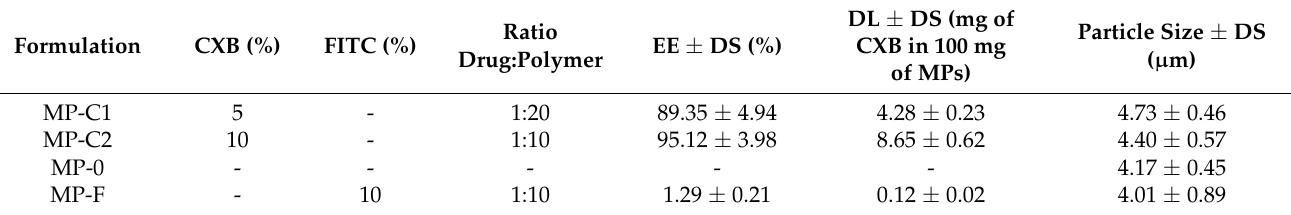
Table 1. Composition of microparticle formulations developed, and their encapsulation efficiencies (EE%), drug loading (DL) and particle size. CXB (celecoxib) and FITC (fluorescein-5-isothiocyanate).